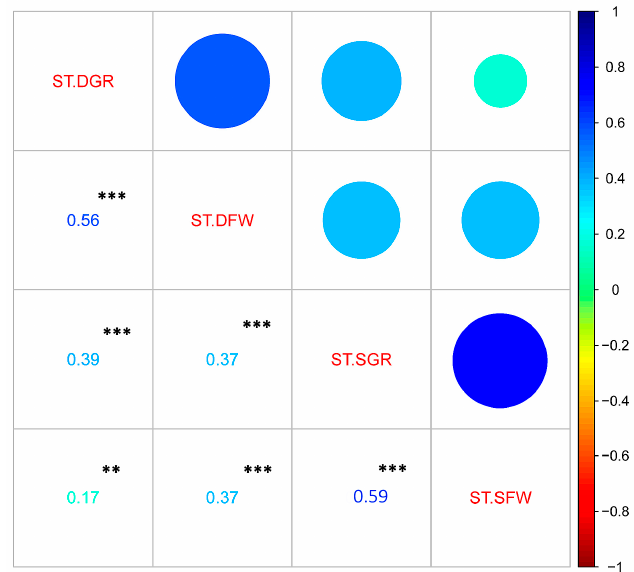
Figure 4. Correlation analysis of the stress tolerance indexes. ***, ** Significant difference at p < 0.001 and p < 0.01, respectively.